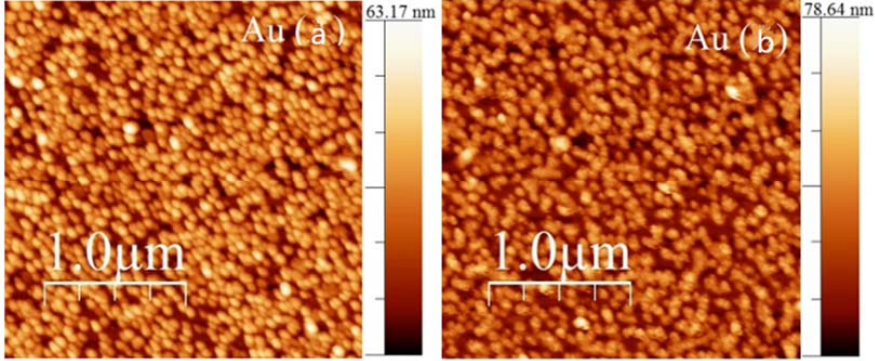
Figure 9. Atomic force microscopy (AFM) images of the surfaces of coatings ( A ) and ( B ), as labeled.